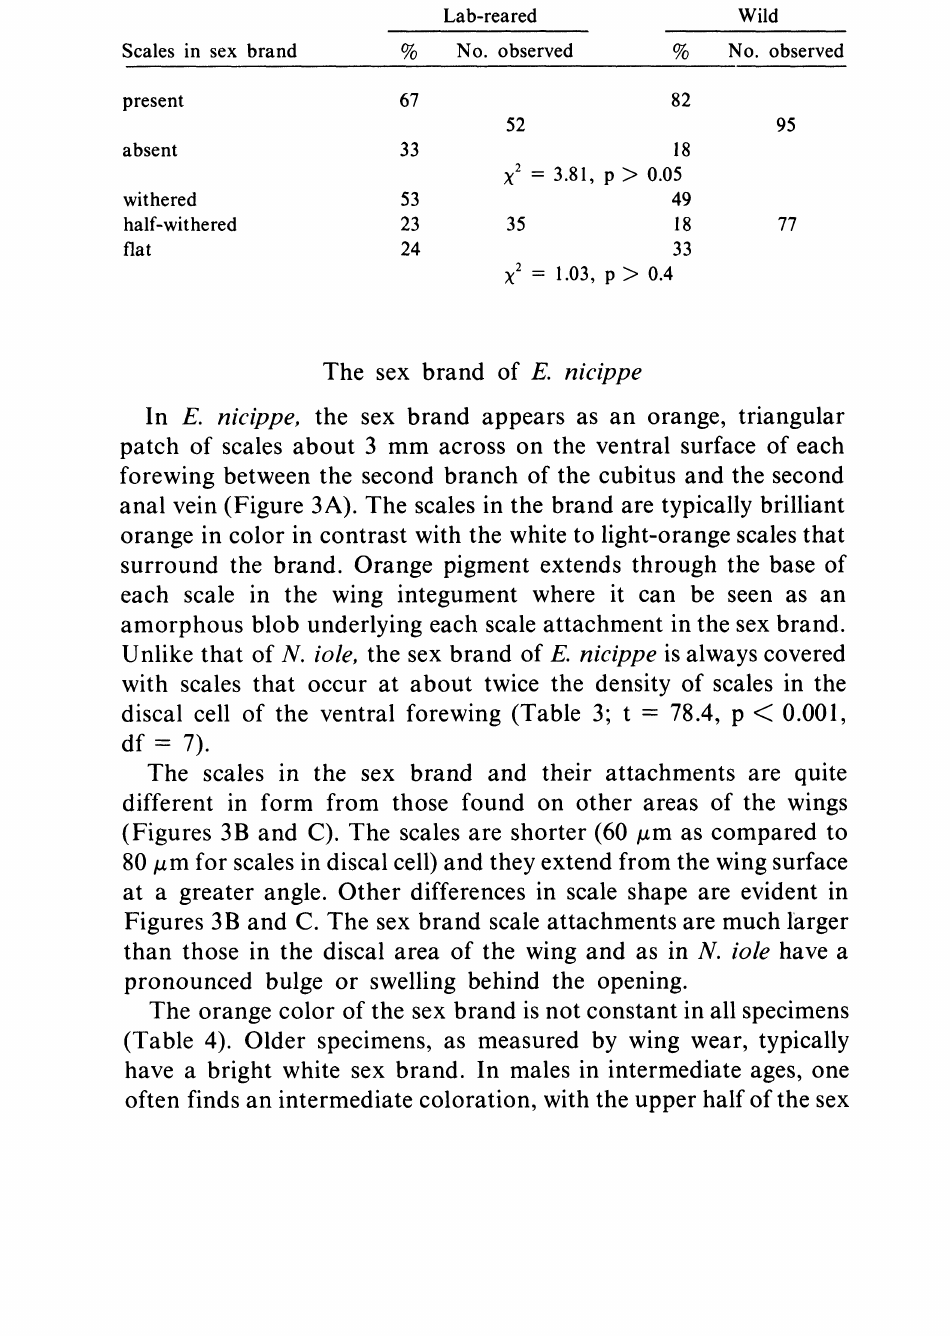
Table 2. Differences between lab-reared and wild males of N. iole with respect to the presence and condition of scales in the sex brand. Lab-reared Wild Scales in sex brand % No. observed % No.